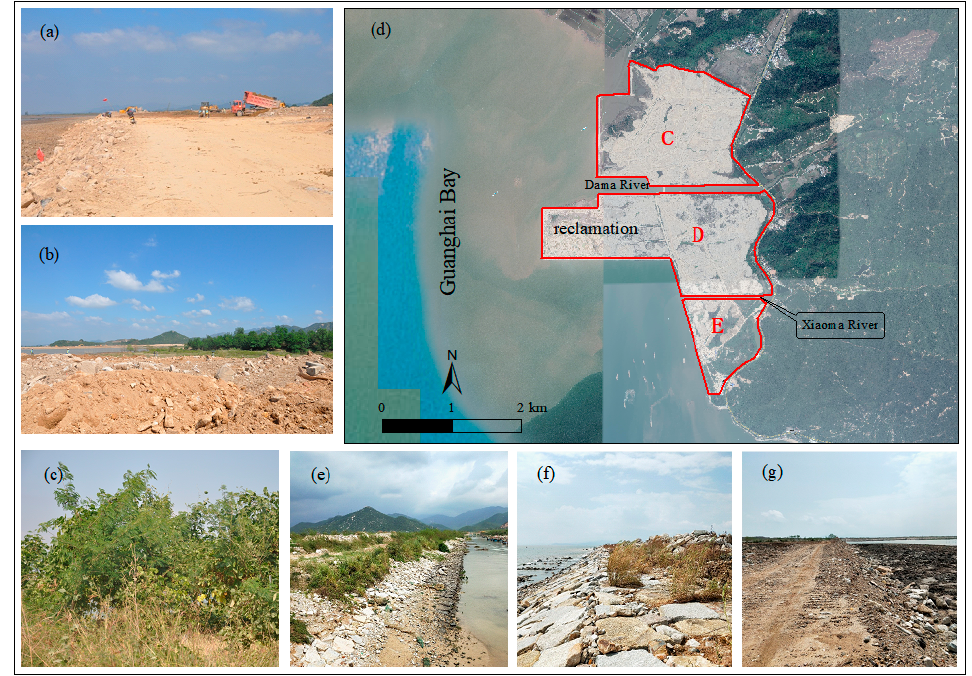
Figure 4. ( a ) ( b ) Soil in the reclamation area; ( c ) Plants in the reclamation area; ( d ) Reclamation layout; ( e ) Sloping shoreline in area C; ( f ) Sloping shoreline in area D; and ( g ) Sloping shoreline in